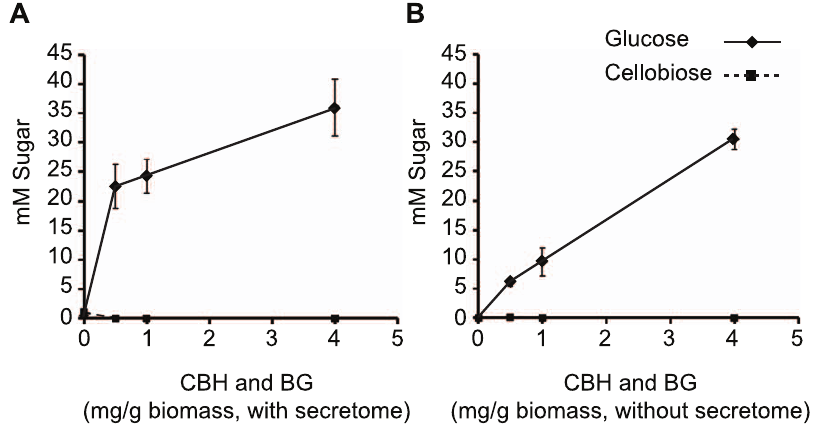
Figure 3. Enzymatic saccharification of IL-pretreated switchgrass by JTherm at 70 6 C pH 5.5. The supernatant from the thermophilic community at fixed concentration of 0.6 6 was augmented with various amounts of CBH and BG, and liberated glucose ( ¤ ) and cellobiose ( & ) from IL-pretreated switchgrass were measured after 72 h incubation. Enzyme combinations were as follows: (A) supernatant, CBH, and BG; (B) CBH and BG without supernatant. The reaction was in a 1 ml volume with 25 mg of IL-pretreated